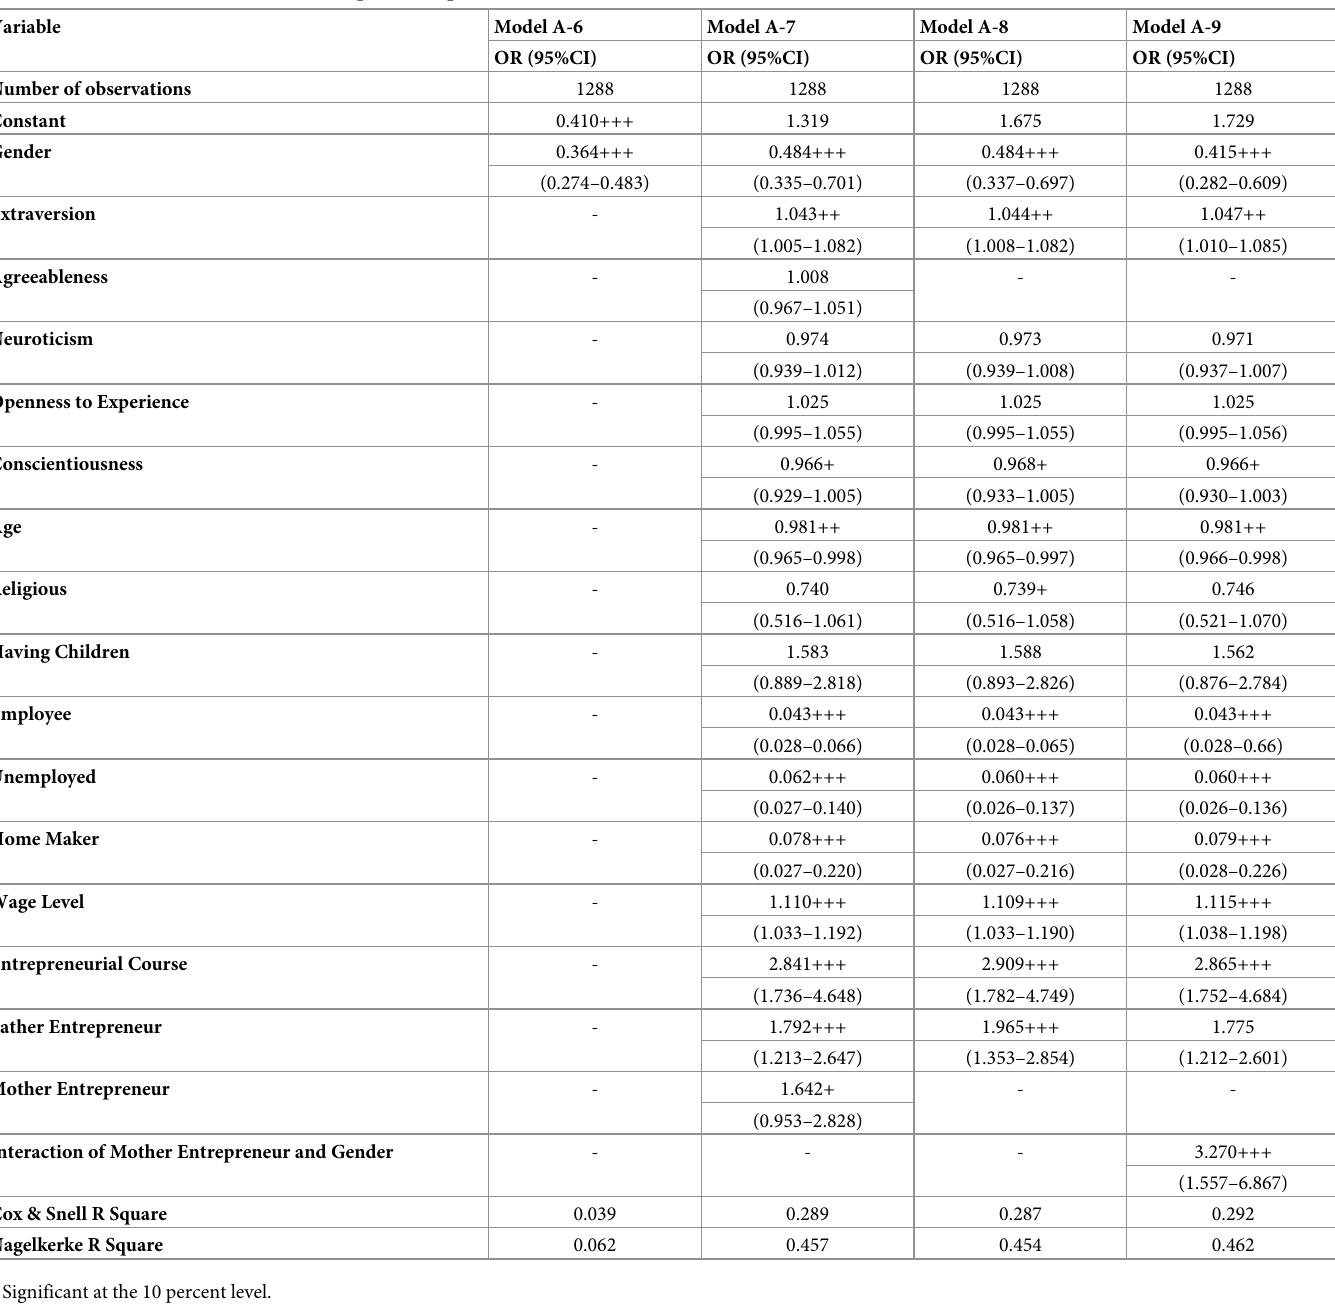
Table 4. Factors associated with actual